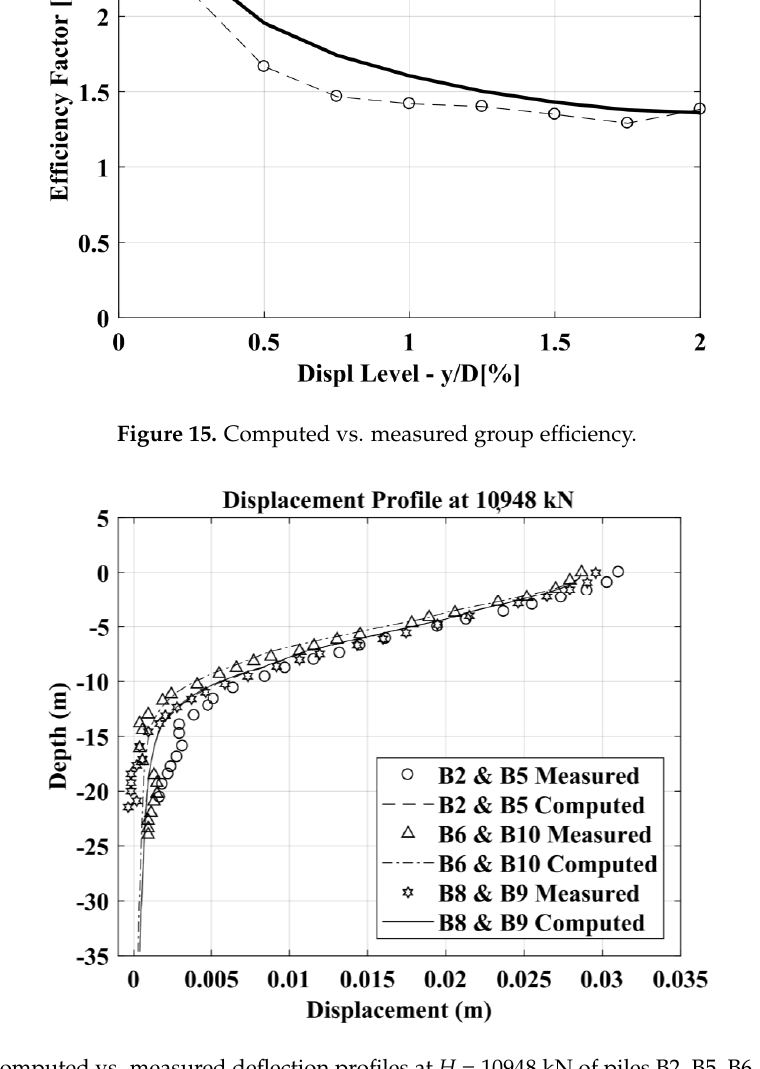
Figure 16. Computed vs. measured deflection profiles at H = 10948 kN of piles B2, B5, B6, B8, B9, B10.